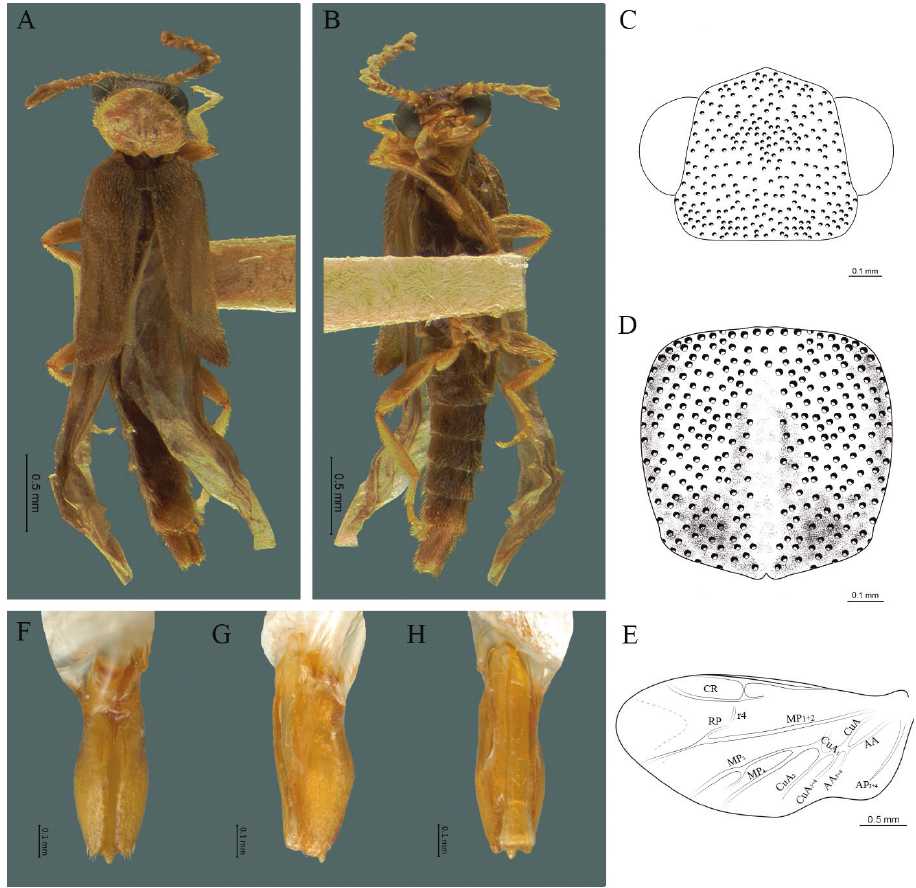
Figure 2. Cenophengus debilis LeConte, 1881, male. Habitus: A dorsal B ventral C head dorsal D pronotum dorsal E hind wing. Wing venation: CR = Radial Cell; r3 = radial 3 vein; r4 = radial 4 vein; RP = Posterior Radial vein; MP1+2 = Posterior Median vein; CuA = Cubital vein; AA and AP = Anterior and Posterior Anal veins. Aedeagus: F dorsal view G lateral view H ventral